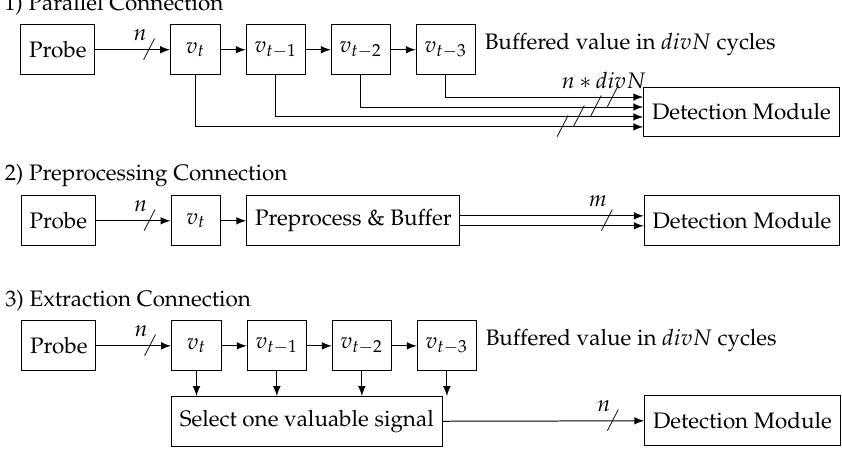
Figure 4. Probe connection types for low-frequency hardware Detection